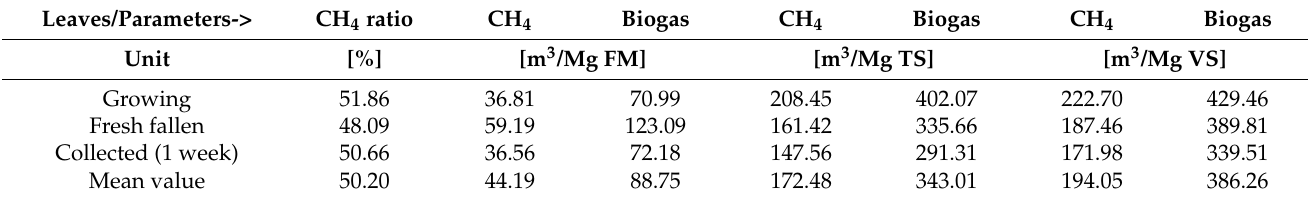
Table 3. Methane content in biogas, biogas, and methane